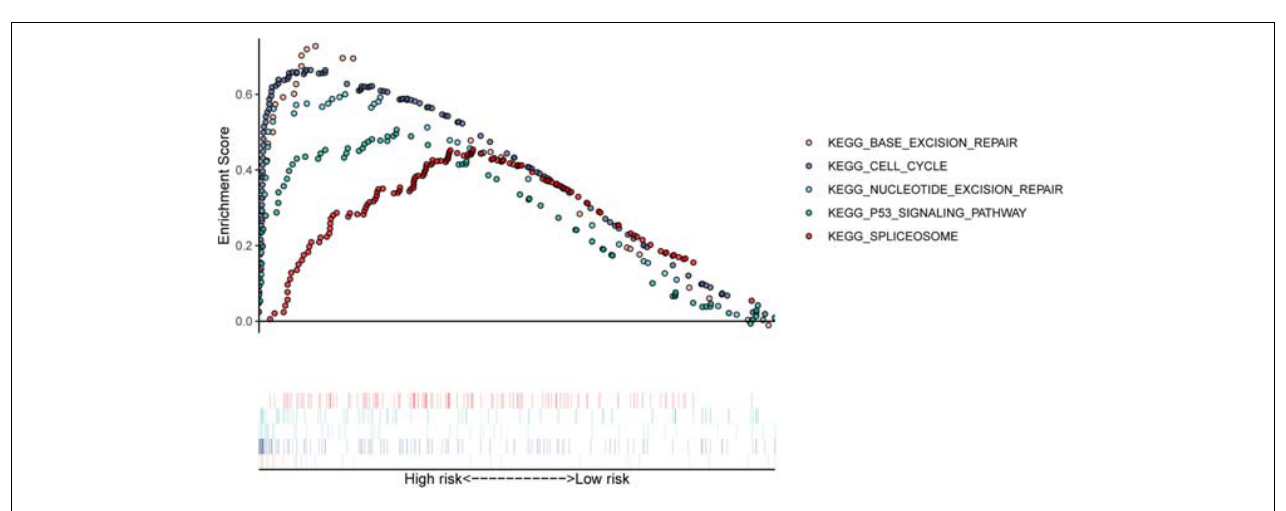
FIGURE 7 | The eight-gene model can enhance the predictive power of R-ISS and ISS for their respective stage II cohorts. (A) R-ISS stage II in GSE136337. (B–D) ISS stage II in GSE136337, TCGA-MMRF, and GSE24080. (Red: a group that was reclassified as high risk. Green: a group that was reclassified as low risk. Blue: total group before reclassification.)